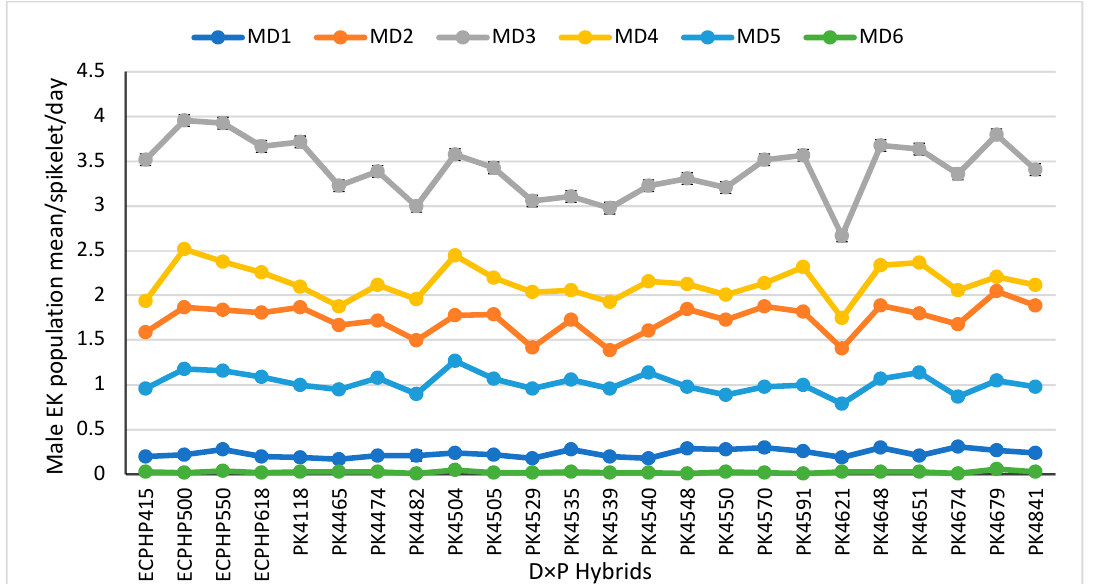
Figure 3. Population means of male Elaeidobius kamerunicus per spikelet on each stage of anthesis in biparental hybrids. Mean ± standard error are presented in the figure as each data point: MD1 (male day-one), MD2 (male day-two), MD3 (male day-three), MD4 (male day-four), MD5 (male day-five), MD6 (male day-six); ECPHP, Elaeis guineensis crossing program Hulu Paka; PK, Porim Kluang; Tukey’s studentized range (HSD) at p ˂ 0.05.